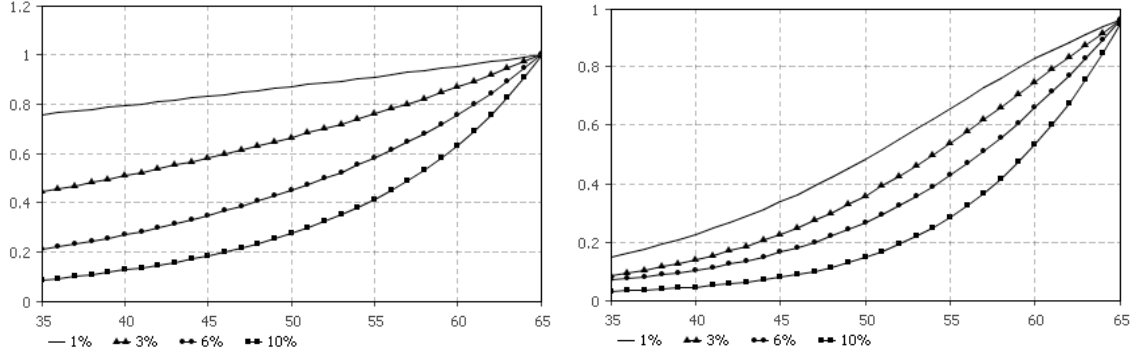
Figure 1. Distribution of the present actuarial Figure 2. Distribution of the present actuarial value of benefits for the case of mixed life value of benefits for the case of insurance